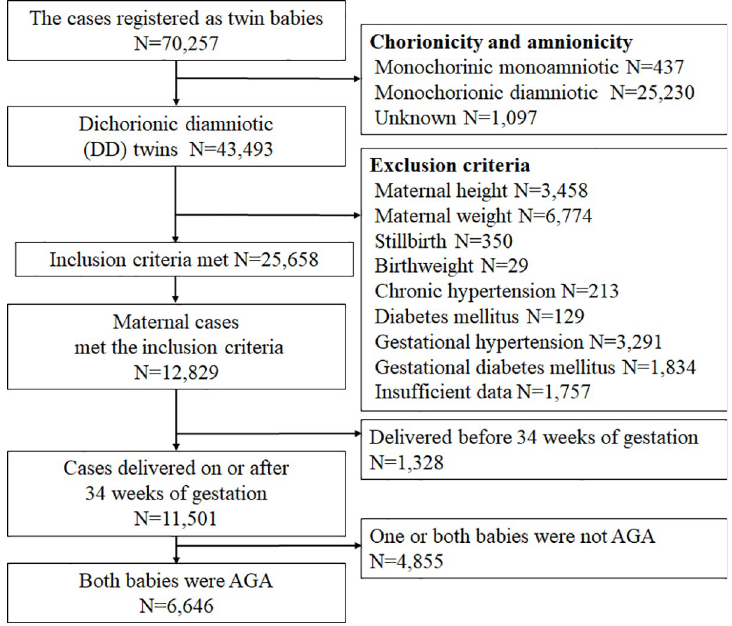
Fig 1. Flowchart depicting the extraction of the eligible cases from the JSOG database. Each newborn is registered in the perinatal JSOG database. A total of 70,257 newborns were registered as twins. Of these, 25,658 newborn cases met the inclusion criteria and were included. We selected the cases wherein both babies were AGA and delivered on or after 34 weeks of gestation; accordingly, a total of 6,646 women with DD twin pregnancy were included.